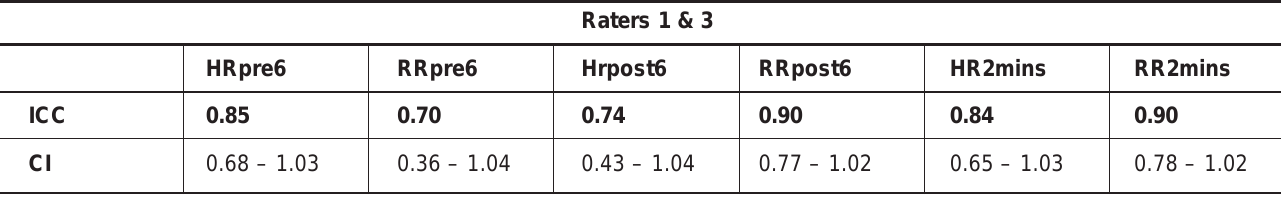
Table 3: ANOVA results for inter-observer correlation for 6-minute walk test (n = 18).